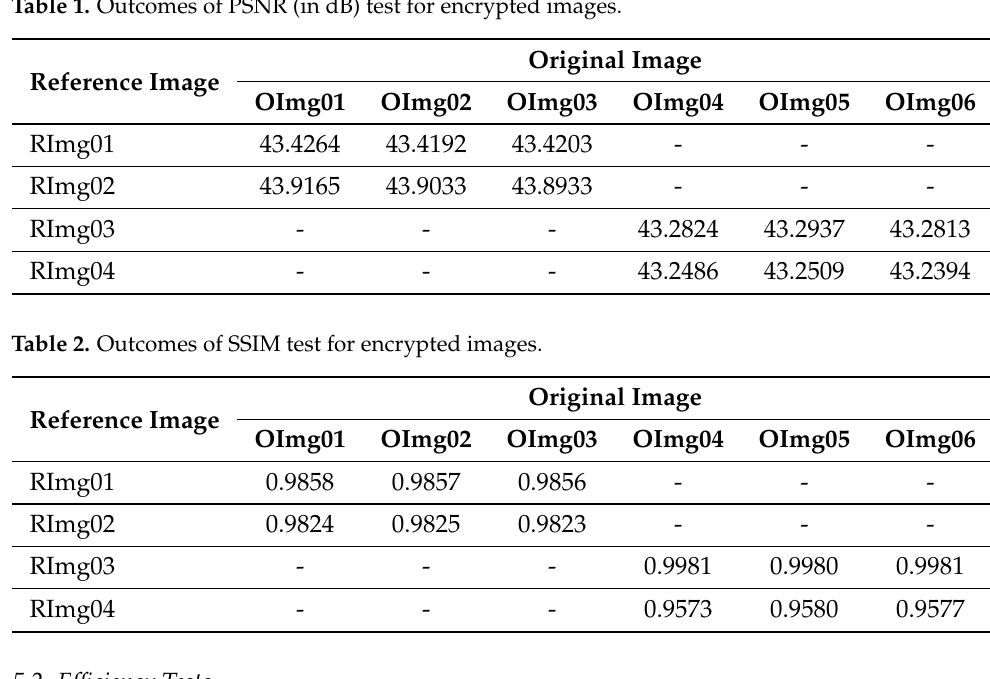
Table 1. Outcomes of PSNR (in dB) test for encrypted images.